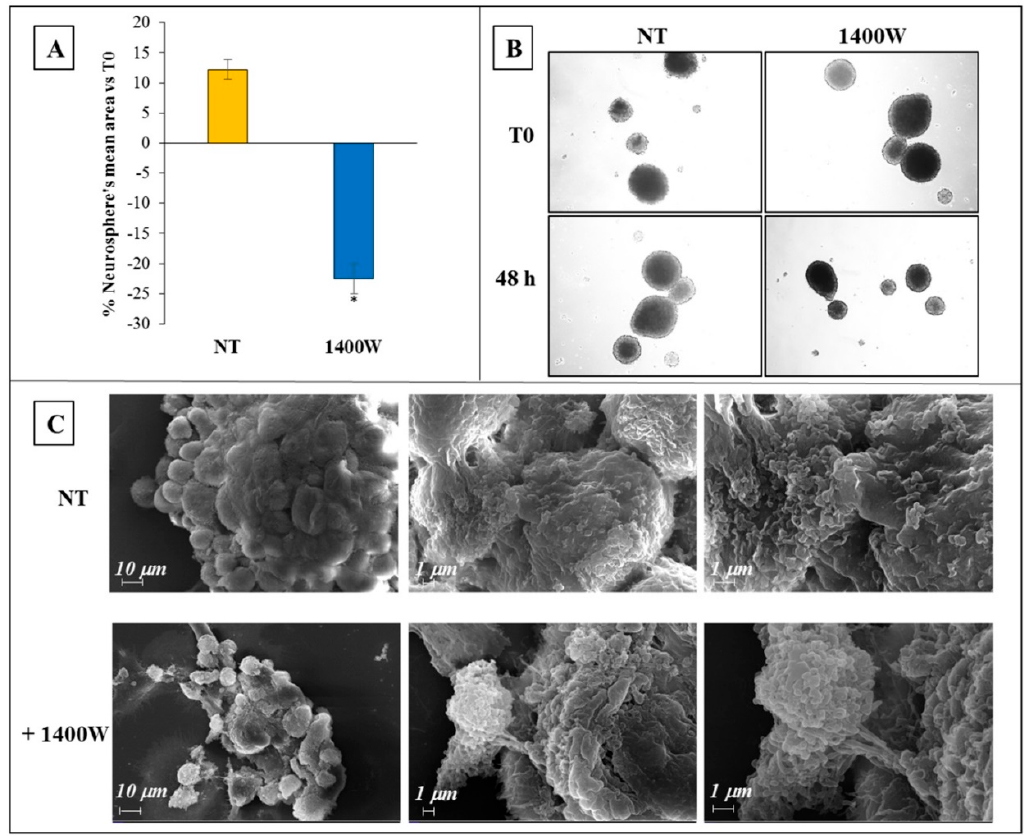
Figure 2. E ff ect of 1400W on U87MG-derived neurospheres (NS) growth. ( A ) U87MG cells were maintained for 7 days in a specific medium (DMEM / F12 + B27 + EGF + b-FGF) to allow NS generation afterwich NS were incubated in the absence (not treated, NT) or presence of 1400W (100 µ M) for 48 h. Quantitative analysis of NS mean area is expressed as percentage vs. relative T0. The results representative of two independent experiments are expressed as mean values of duplicates ± SD. For comparison between two means, Student’s unpaired t -test was used (* p < 0.05). ( B ) Representative phase contrast images (4 × magnification) of human U87MG-derived NS in the absence (NT) or presence of 1400W (100 µ M) for 48 h. ( C ) Representative scanning electron micrograph images of untreated (NT) or 1400W-treated NS (from left to right: 2000 × , 10,000 × , 20,000 × magnification, respectively).